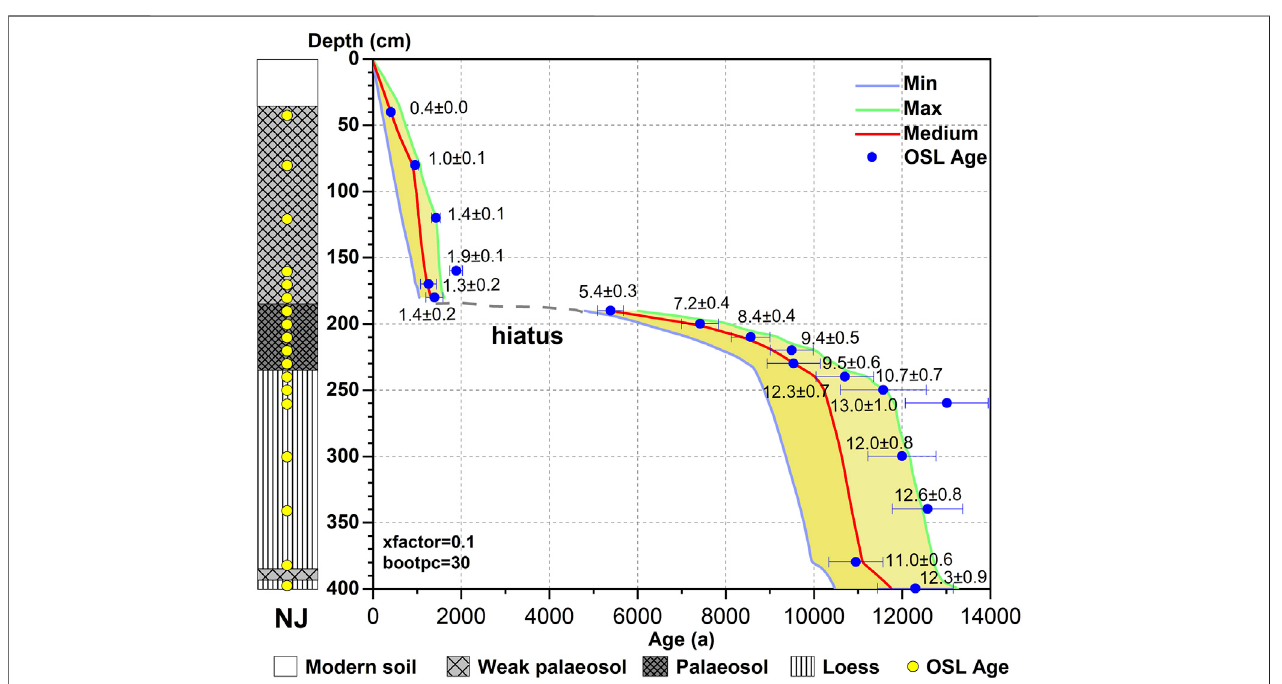
FIGURE 2 | Age-depth relationship for the NJ section based on the Undatable model (Lougheed and Obrochta, 2019).